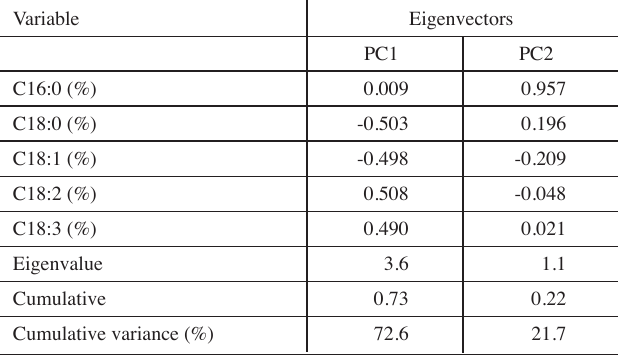
Tab. 4: Eigenvectors and Eigenvalues of the first two principal components for the 5 main FAs in seed oil of 50 breeding lines of L.